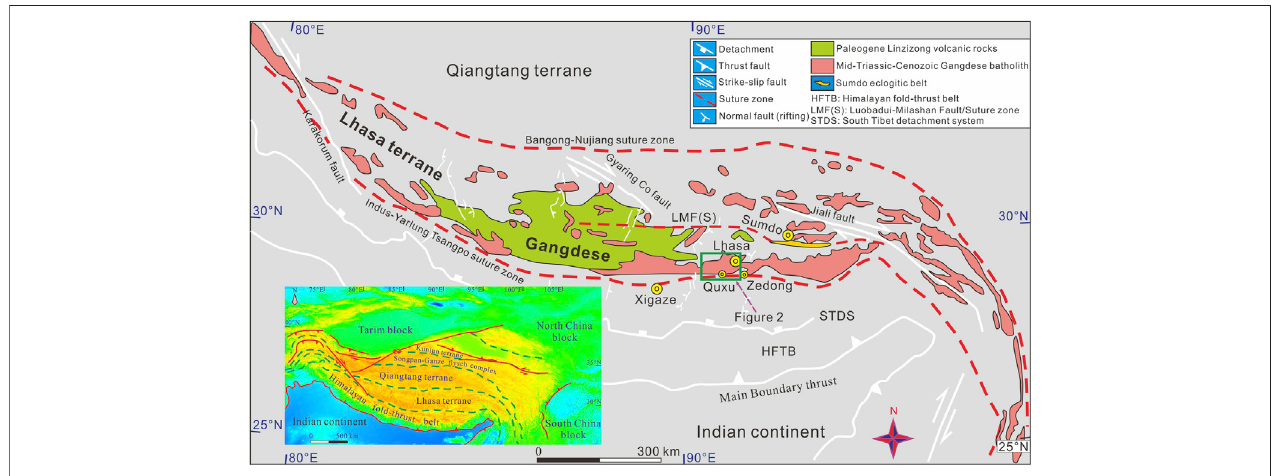
FIGURE 1 | Simpli fi ed geological map of the Gangdese magmatic belt in the southern Lhasa terrane showing the location of the Quxu batholith.